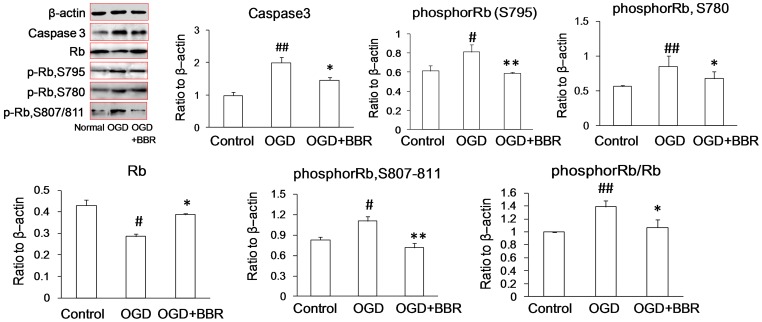
Expressions of Rb and phosphor-Rb (p-Rb) in primary neurons as measured by Western blot.Berberine (BBR) (0.5 µg/ml) was added in the culture 1 h before OGD treatment and throughout reperfusion. Data are presented as mean ± S.D. of three independent experiments (n = 3). # P<0.05, ## P<0.01 v.s. normal groups; *P<0.05, **P<0.01 v.s. OGD groups.